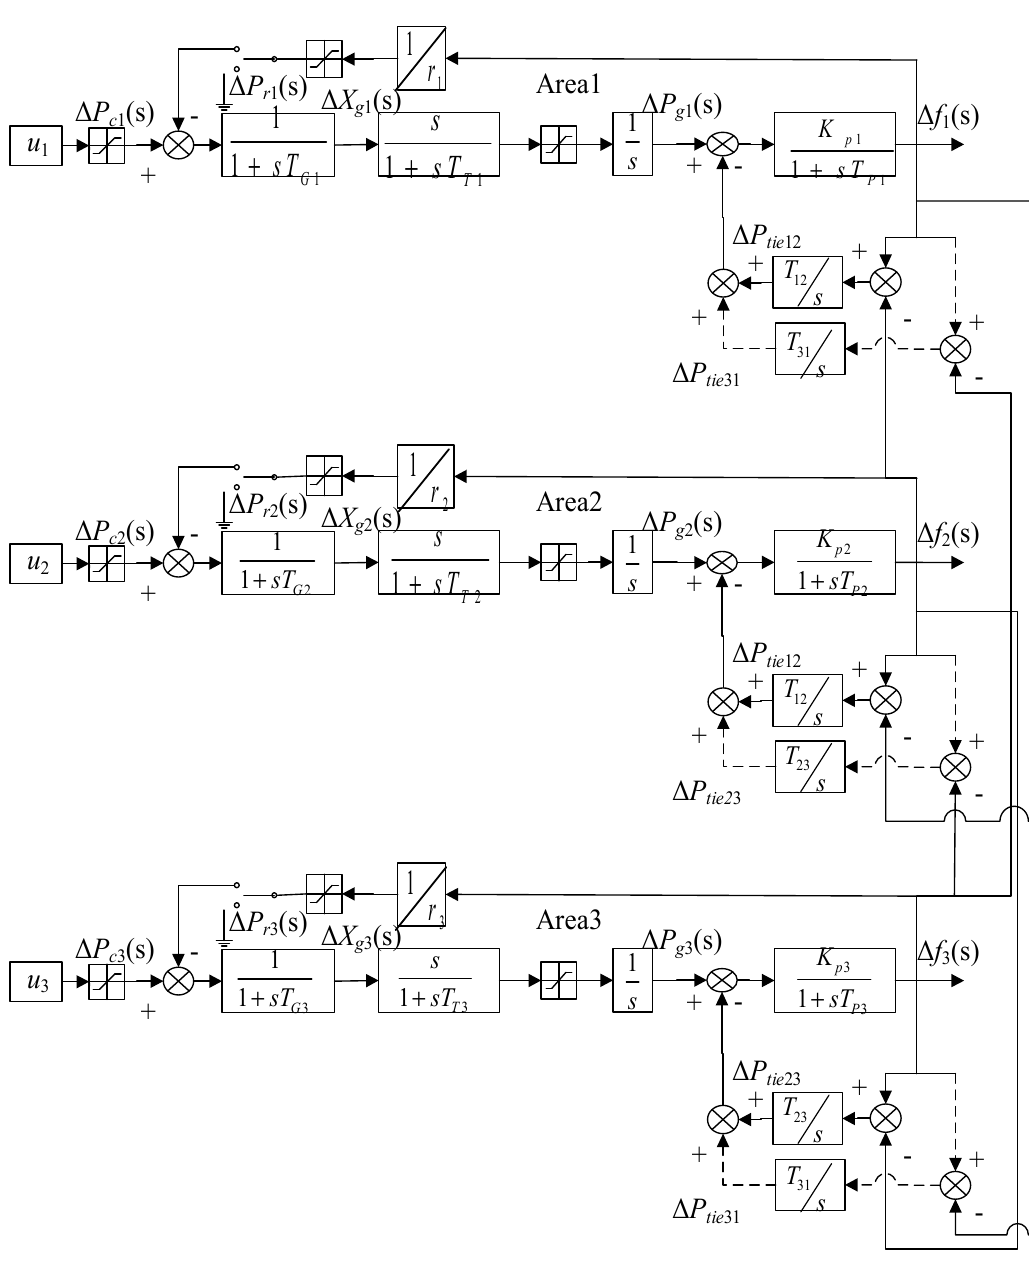
Figure 1. Diagram of interconnected power system with three control areas.